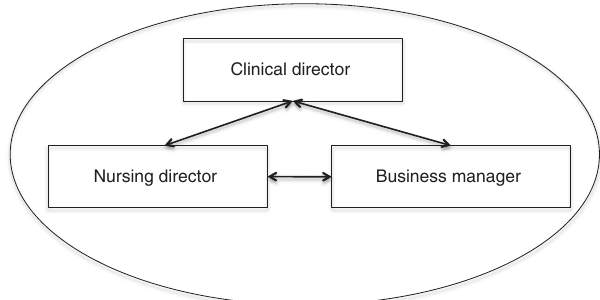
Figure 1. Clinical directorate